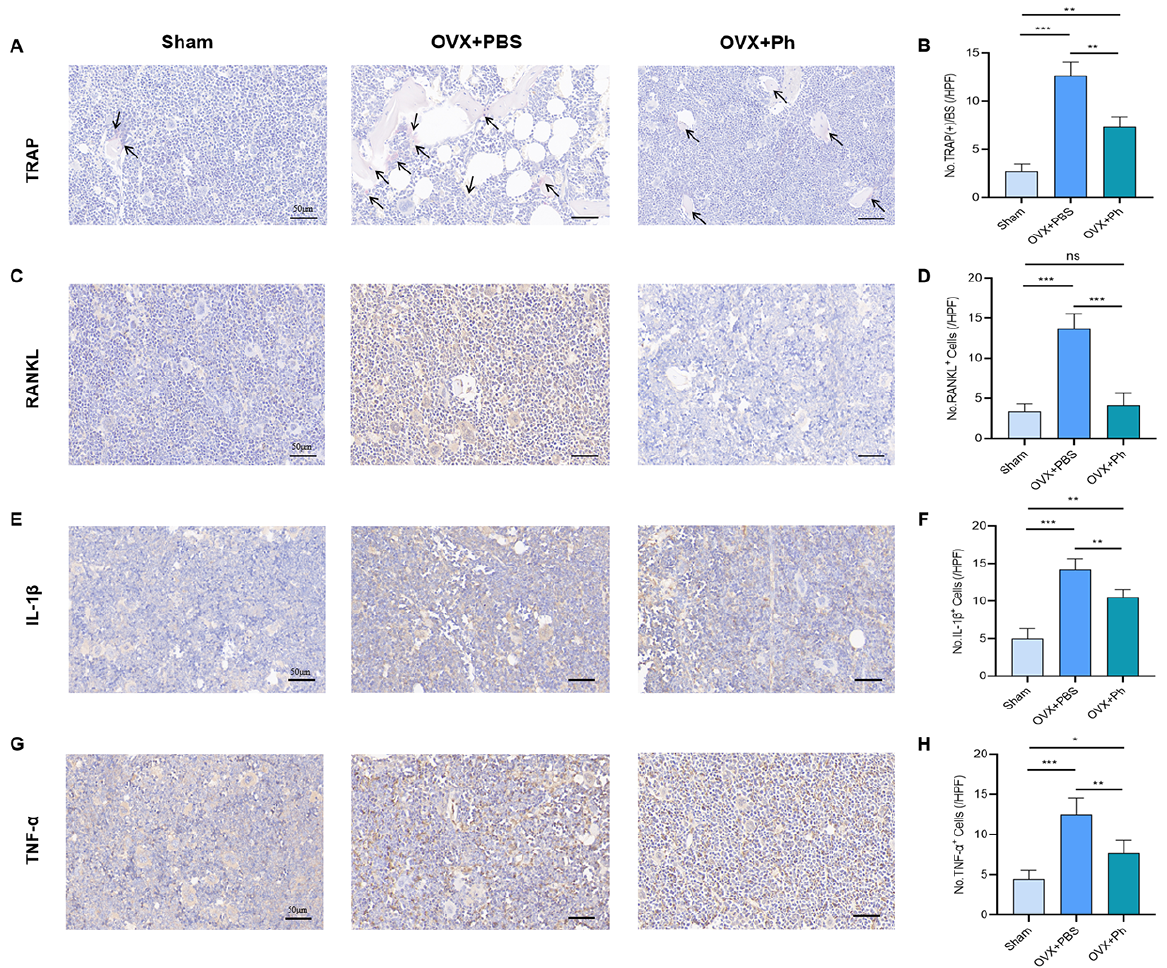
Figure 3. The perfusion of Ph repressed the osteoclastogenesis. ( A ) The TRAP stained the sections of distal femur tissues. The scale bars represented as 50 µ m; ( B ) No. TRAP + cells; ( C ) The RANKL stained the sections of the distal femur tissues. The scale bars represented as 50 µ m; ( D ) No. RANKL + cells; ( E ) The IL-1 β stained the sections of distal femur tissues. The scale bars represented as 50 µ m; ( F ) No. IL-1 β + cells; ( G ) The TNF- α stained the sections of distal femur tissues. The scale bars represented as 50 µ m; ( H ) No. TNF- α + cells. * p < 0.05, ** p < 0.01, and *** p < 0.001 compared